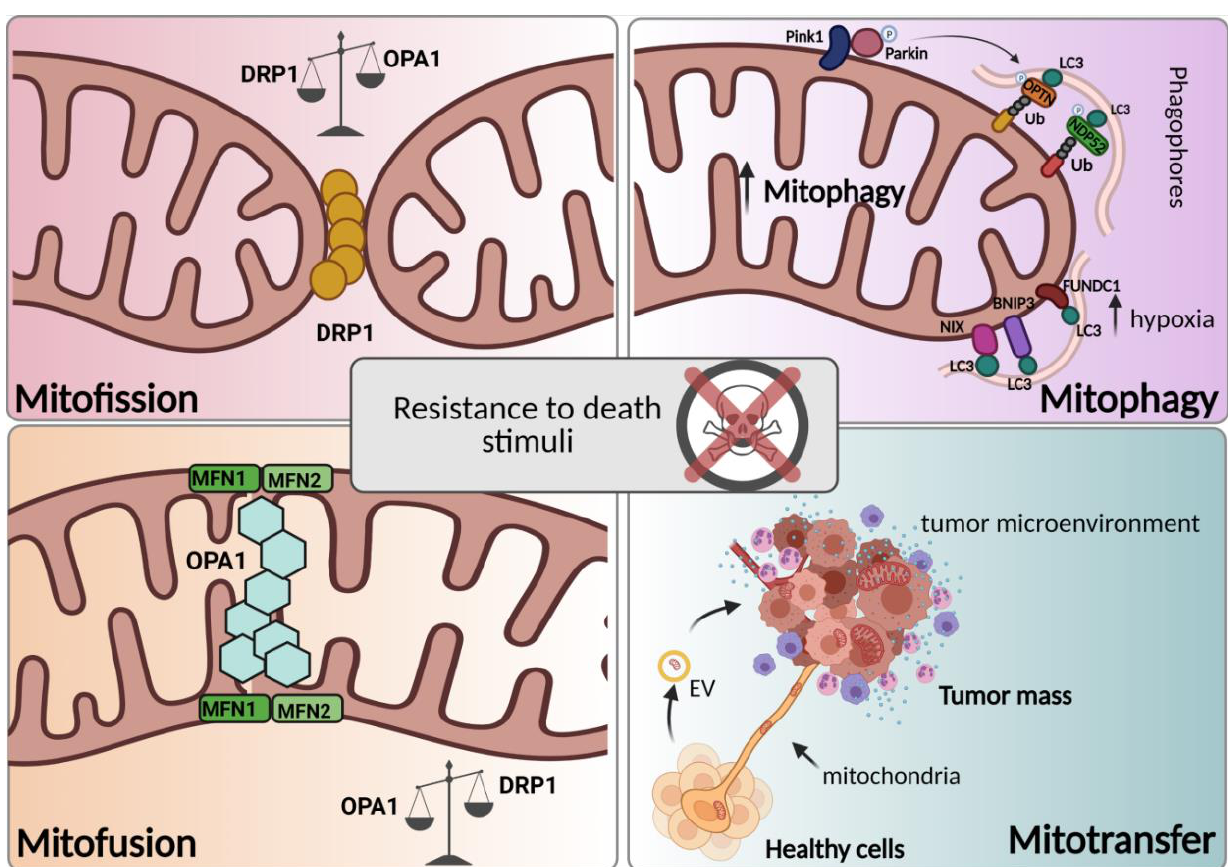
Figure 1. Mitochondrial dynamics in chemoresistance. Mitotransfer, mitophagy, and mitochondrial fusion and fission (respectively, mitofusion and mitofission) are processes related to mitochondrial dynamics. These processes, depending on their activation timing, tumor subtype, and microenvironment, can foster chemoresistance. The details of the processes are reviewed in the paragraph. (Created with Biorender.com, accessed on 18 March 2021).